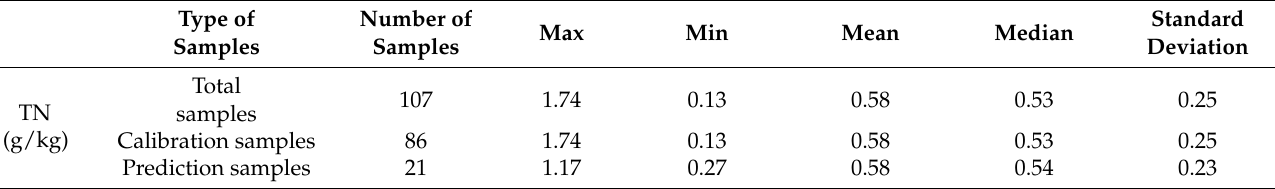
Table 1. Descriptive statistical characteristics of soil TN